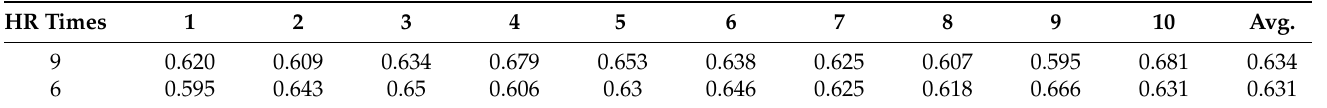
Figure 9. The optimal evolution results of circuits. ( a ) circuit-I. ( b ) circuit-II. (Red mark: the HT-I PEs; Blue Arrow: The data flow). Table 1. Evolution time of circuit-I in different evolvable regions.